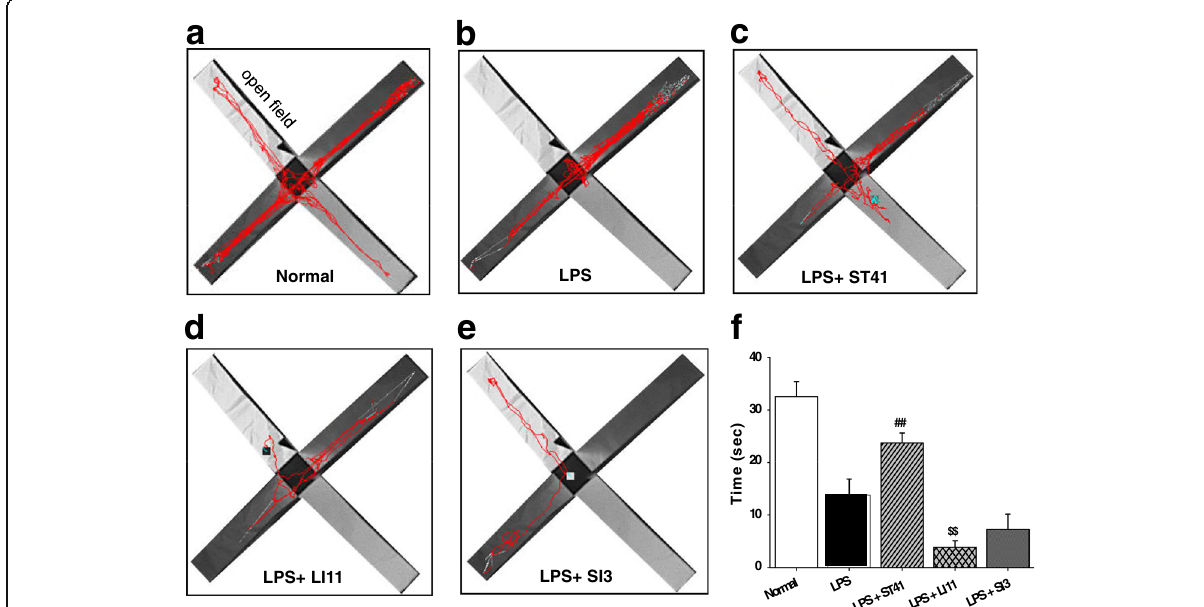
Fig. 2 Effect of acupuncture on LPS-induced anxiety-like behavior in the EPM. a-e Representative examples of traveling pattern for 5 min in the open arms. f Time spent in the open arms for 5 min presented as mean ± SEM. While LPS-administered rats spent less time in open arms compared to normal, acupuncture at ST41, but neither LI11 nor SI3, significantly spent more time in open arms compared to LPS-administered rats. *** P < 0.001 vs. normal, ## P < 0.01 vs. LPS, $$ P < 0.01 vs. LPS; n = 6 – 7 per